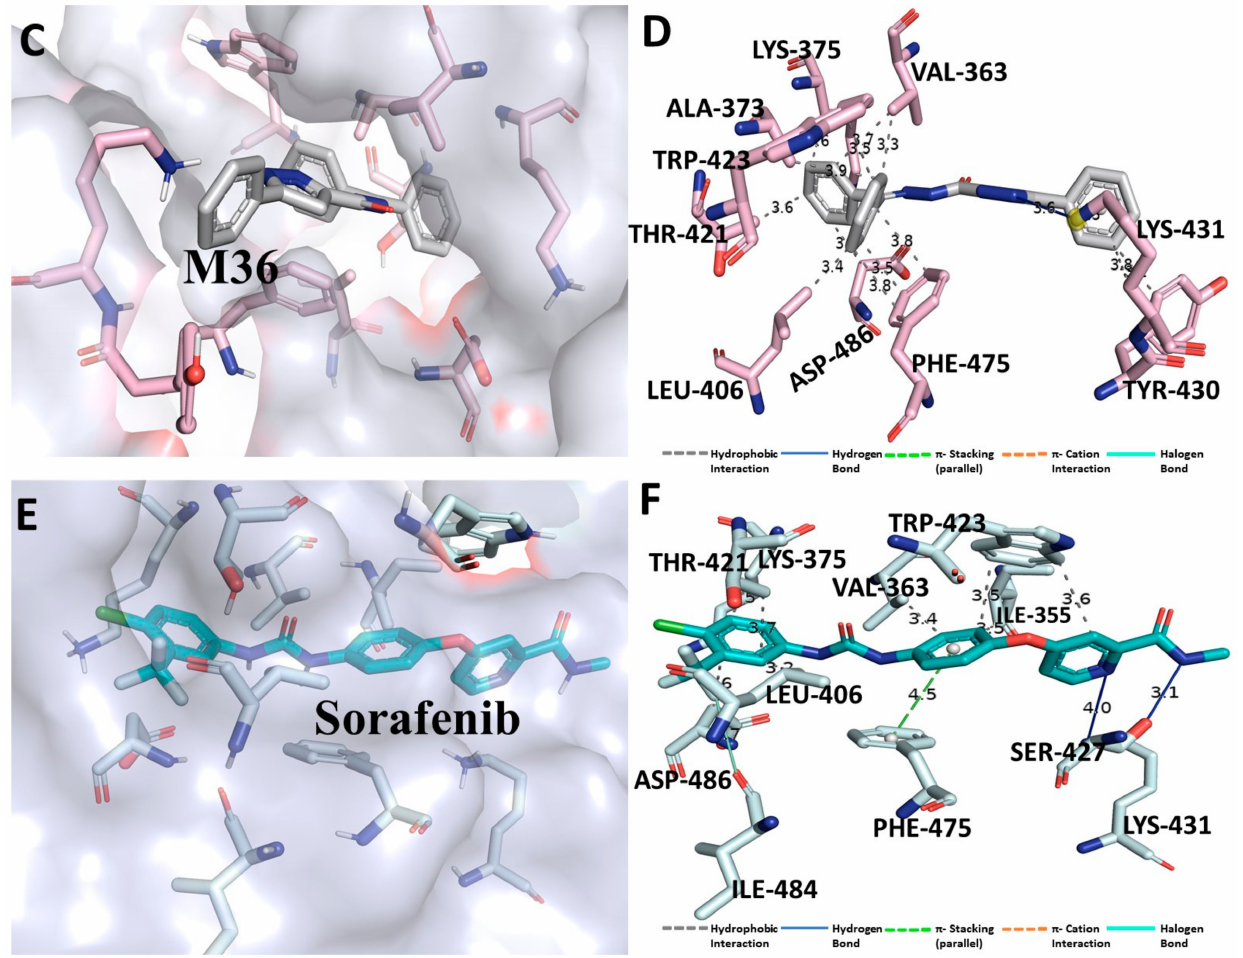
Figure 4. ( A ) Molecular docking-generated binding orientations of standard compound (sorafenib) and the proposed pyrazole-based inhibitor compound M36 in complex with C-RAF (3OMV) protein; ( B ) close-up binding interaction view exhibiting similar binding pattern of all the compounds at the active site cavity of C-RAF (3OMV) protein; ( C ) binding mode of pyrazole compound M36 in the active site cavity of C-RAF (3OMV) in surface view; ( D ) molecular binding interaction and orientation of compound M36 with C-RAF (3OMV) protein; ( E ) binding mode of standard compound (sorafenib) in the active site cavity of C-RAF (3OMV) displayed in surface view; ( F ) molecular binding interaction and orientation of sorafenib with C-RAF (3OMV)